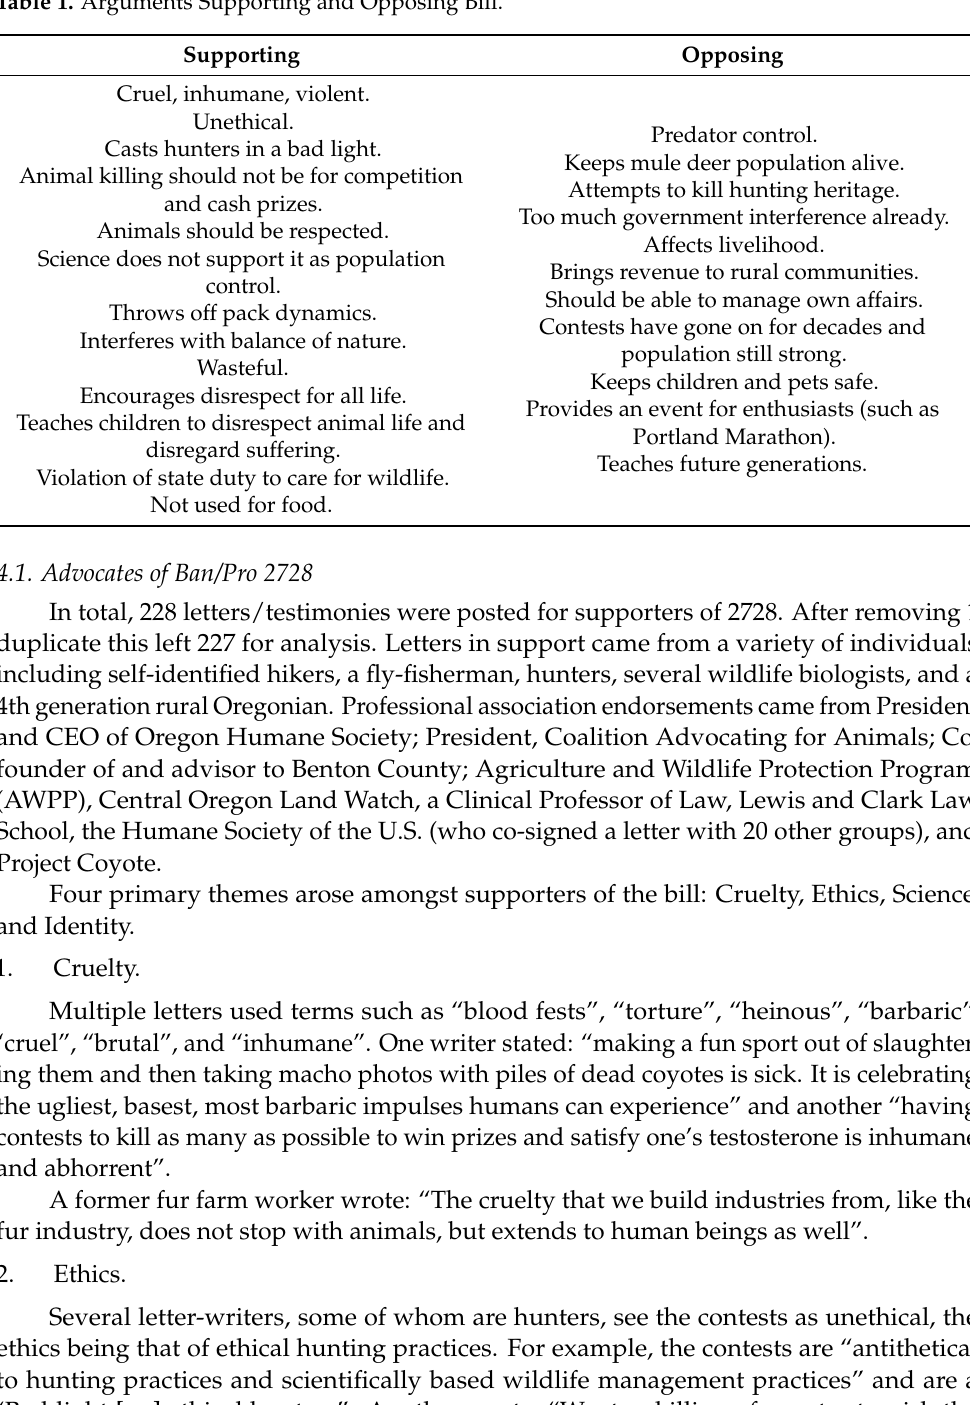
Table 1. Arguments Supporting and Opposing